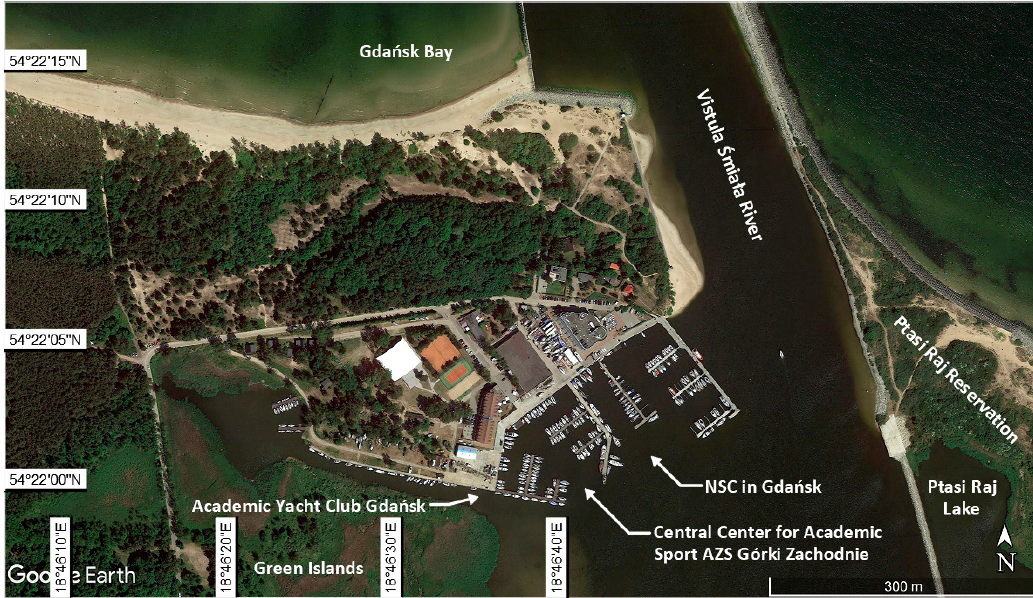
Figure 4. The location of the National Sailing Centre at the Gda ń sk University of Physical Education and Sport (NSC-GUPES).